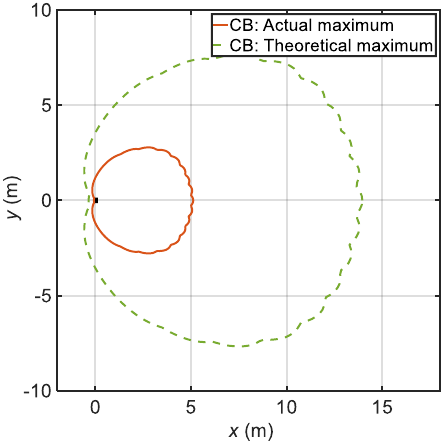
Figure 7. Compliance boundary (CB) or exclusion zone for the BS determined according to EIRP act (red solid line) and the theoretical maximum EIRP (green dashed line).